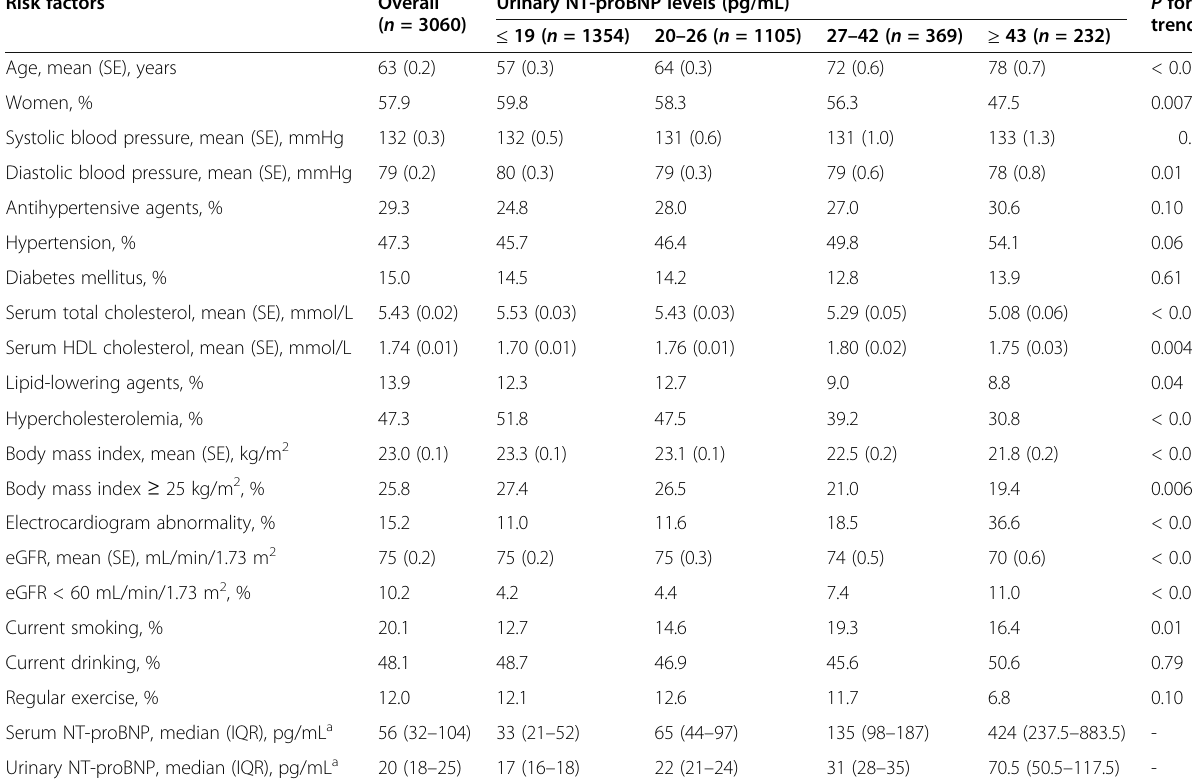
Table 1 Age- and sex-adjusted clinical characteristics according to the urinary NT-proBNP levels at baseline Risk